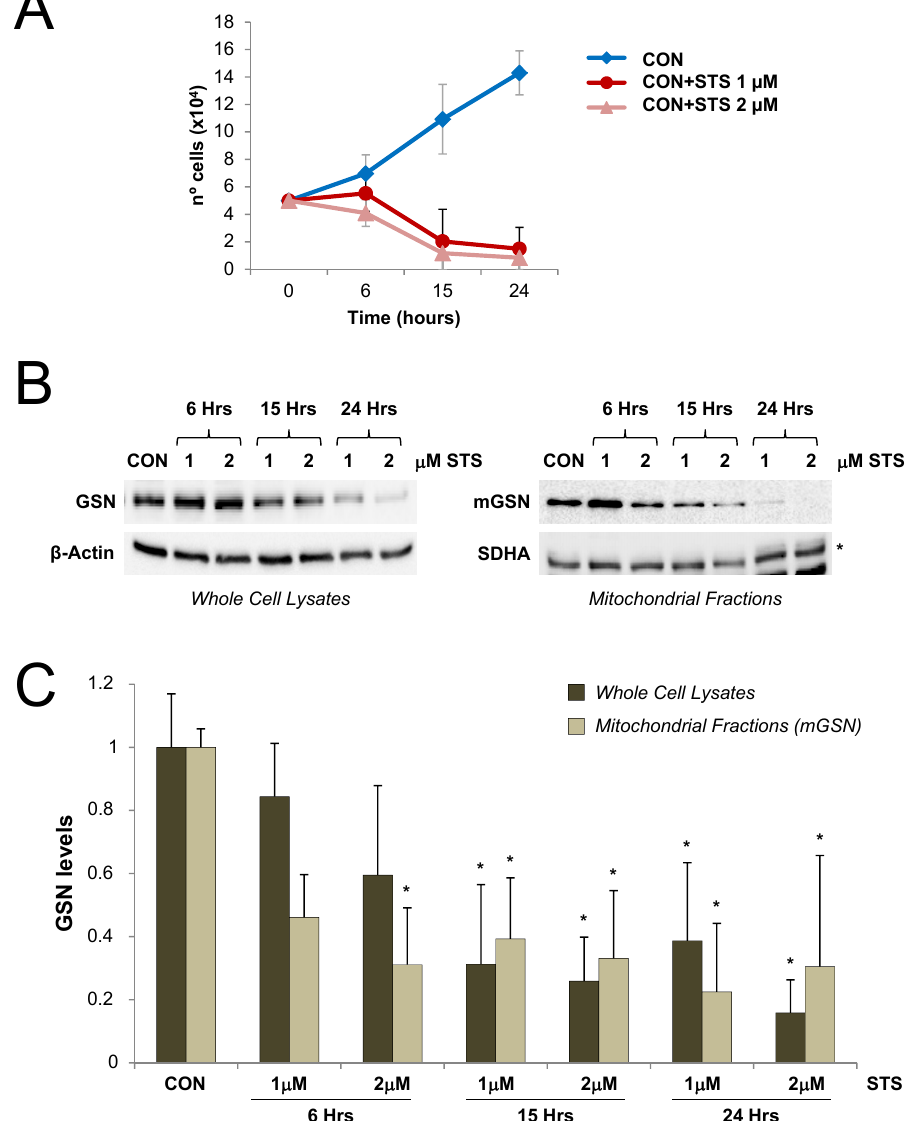
Figure 6. Gelsolin levels decrease upon cell death induction. Control cybrids were cultured for 6, 15, and 24 h in the presence of 1–2 µ M of staurosporine (STS). ( A ) Cell death rates upon STS treatment. Here, 5 × 10 4 cells were seeded in 6-well plates and data are presented as the mean ± SD of three experimental replicates per condition. ( B ) In total, 15 µ g of whole-cell and mitochondrial protein extracts were separated on 10% SDS-PAGE gels and GSN levels were subsequently analyzed by Western blot, using β –actin as the loading control for the whole-cell lysates, and SDHA for the mitochondrial fractions (indicated with an asterisk). ( C ) The signals from four independent experiments were quantified and normalized by their respective loading controls. Data are presented as the mean ± SD relative to the untreated cells (CON) values, set as 1. Mann–Whitney U test: * p < 0.05. GSN, cytosolic GSN; mGSN, mitochondrial